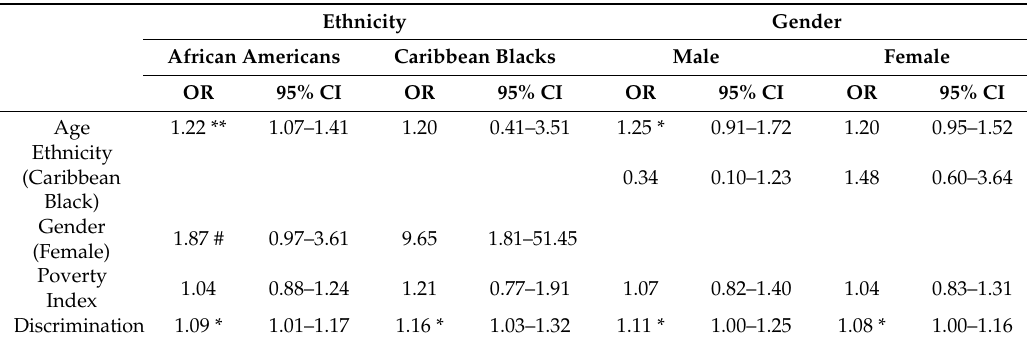
Table 3. Summary of logistic regressions for the associations between discrimination and suicidal ideation based on ethnicity and